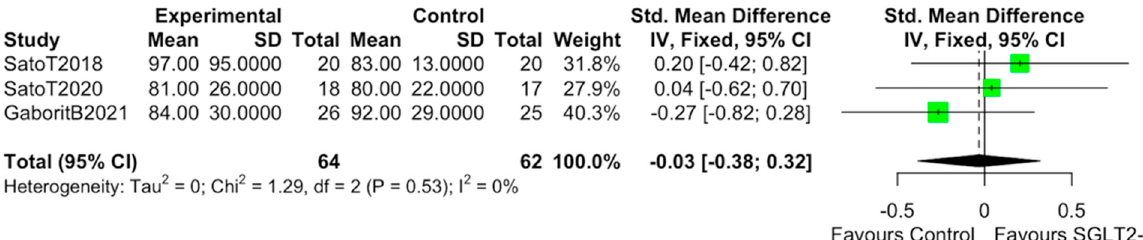
Figure 6. Effect of SGLT2-i therapy on HDL. Fixed − effects, standardized mean difference (SMD), 95% confidence intervals (CI), and I2 statistics.